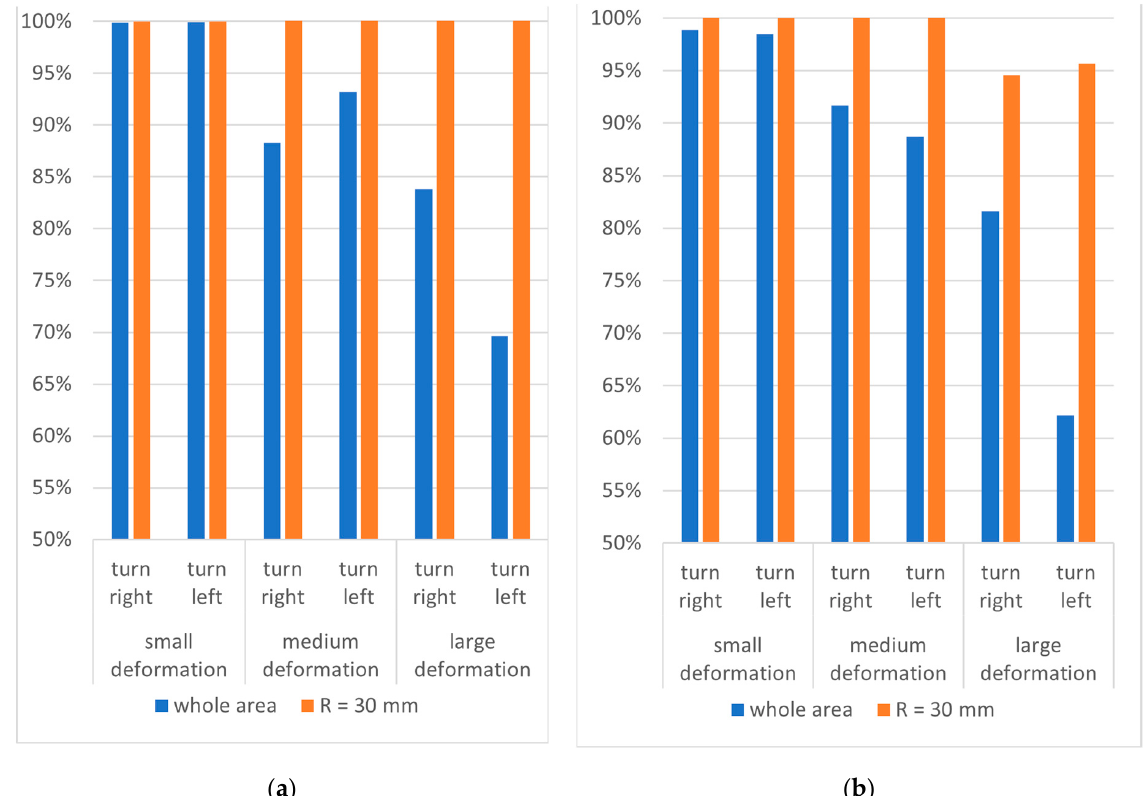
Figure 14. The share of positively matched markers for the entire pattern and in the area of radius R = 30 mm around the center of the marker grid, for three exemplary pairs of images, depending on the direction of rotation of the matching points without removing the classified markers: ( a ) Variant W1; ( b ) W2.